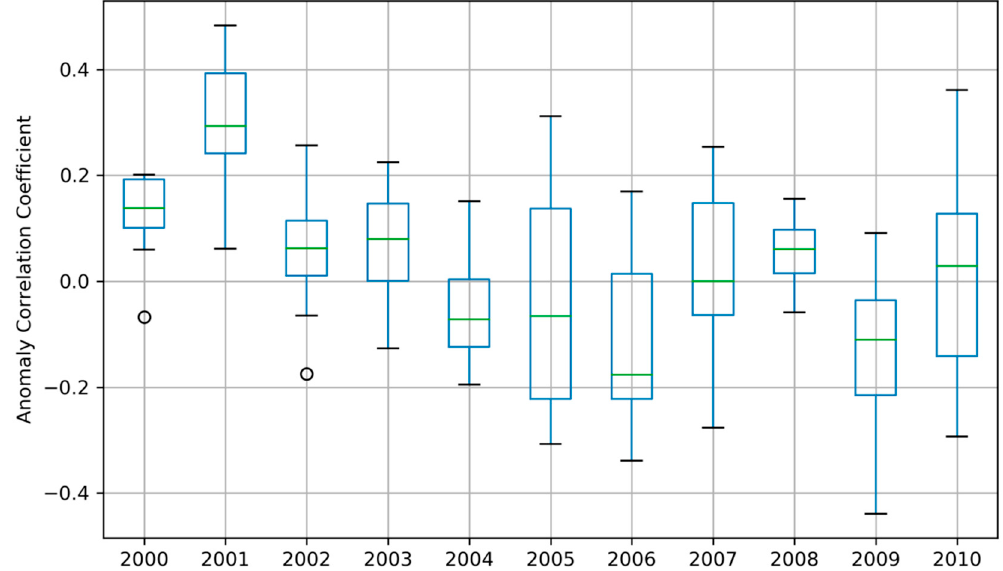
Figure 8. Spatial verification using the anomaly correlation coefficient. The calculation was done for each of the 15 SYS4 ensemble members (initialized in February) compared to CHIRPS for the entire study region. The statistics used for the visualization of the box and whisker plots are the same as Figure 6.